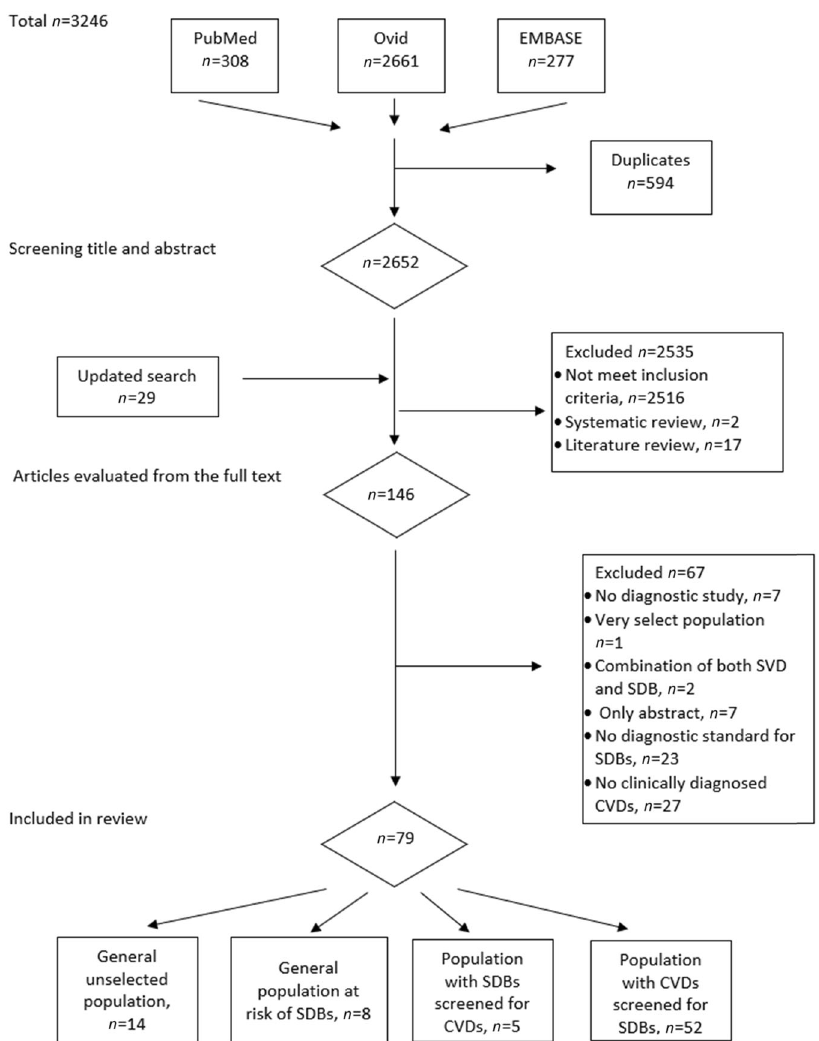
Fig. 1 Flow chart of the study selection process for meta-analysis. SDB sleep-disordered breathing, CVD cardiovascular